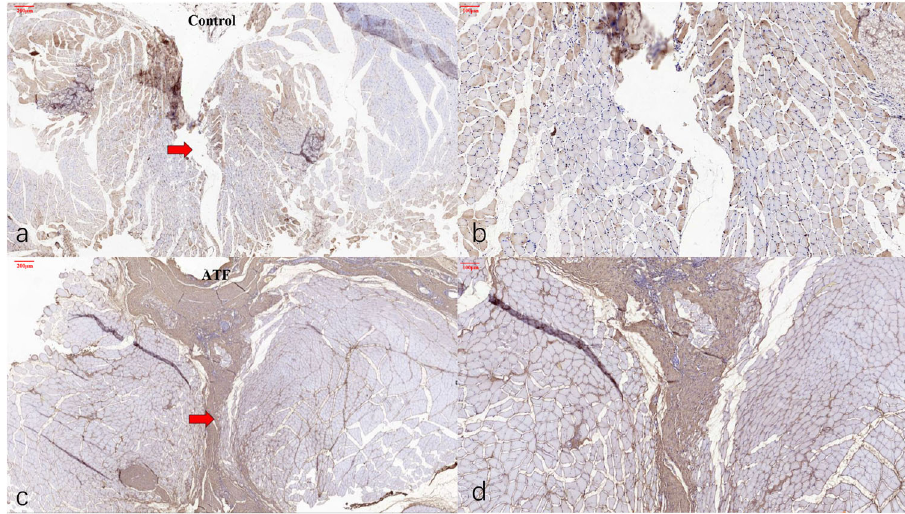
and no low amplitude or shortened phase, but frequency of evoked potential in control group was lower than ATF group; c ATF group EMG examination showed straight baseline without pathological wave